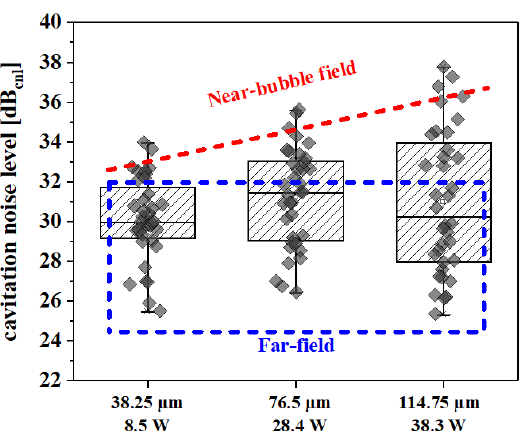
Figure 2. Measured cavitation noise level in the sonophotocatalytic reaction zone beneath the UV − LED system.